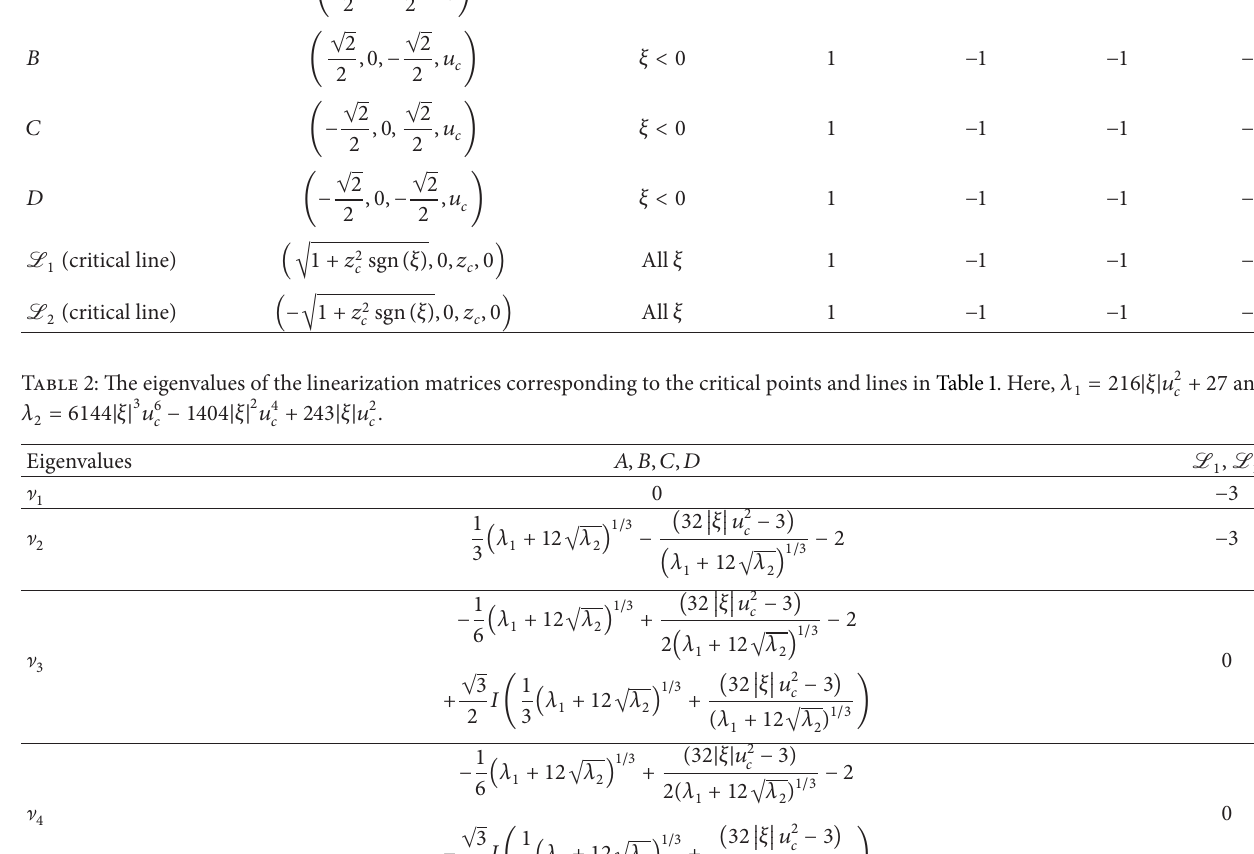
Table 1: Location and condition for existence of the critical points and the corresponding values of the dark energy density parameter Ω of dark energy equation of state parameter 𝜔 Label Location of (𝑥 𝑐 ,𝑦 𝑐 ,𝑧 𝑐 ,𝑢 𝑐 )